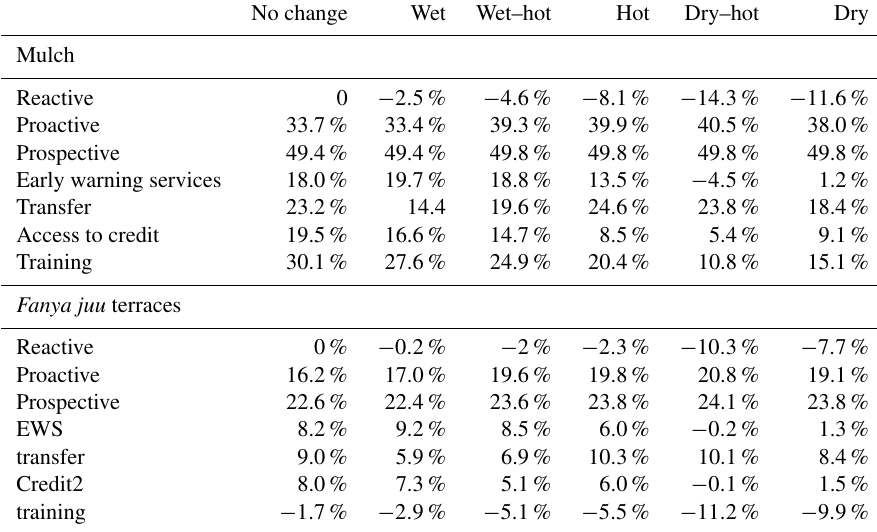
Table B2. Difference in adoption ratio (as a share of the population) under different climate and intervention scenarios compared to the reactive government scenario under no climate change (the BAU